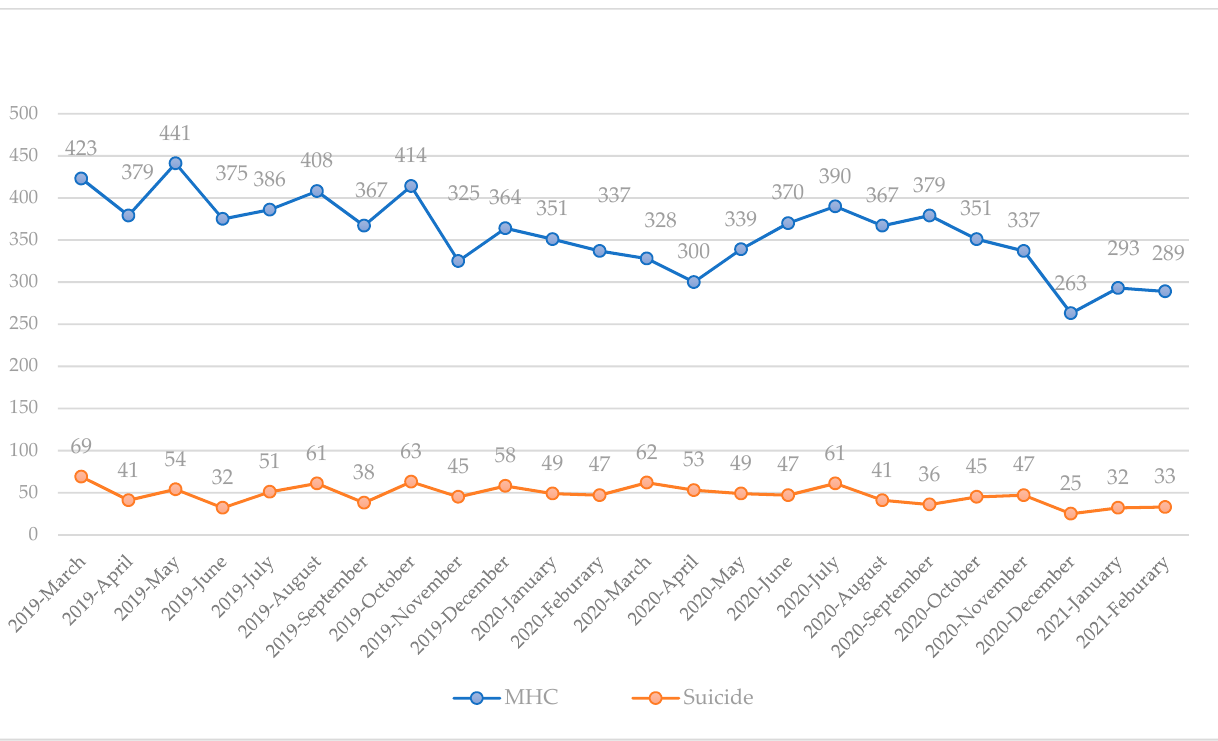
Figure 1. Flow chart of the study population.EMS, emergency medical service; MHC, mental health crisis; COVID ‐ 19, coronavirus disease ‐ 2019.